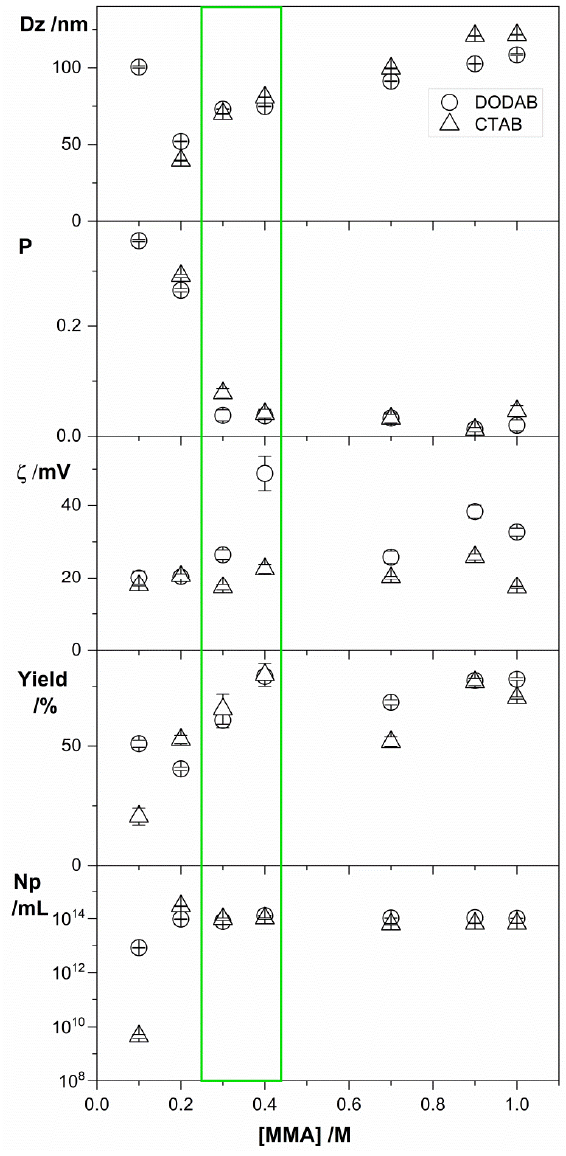
Figure 2. Physical properties of PMMA/QAC NPs obtained by emulsion polymerization over a range ○ of [MMA] at 2 mM DODAB ( ) or CTAB ( ∆ ). All dispersions were exhaustively submitted to